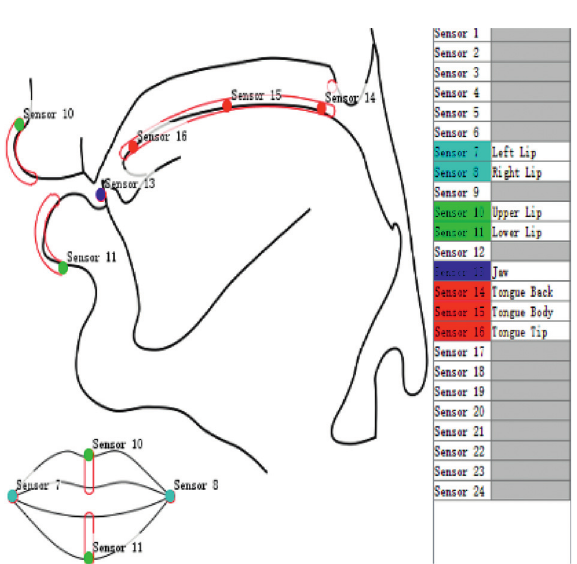
Figure 5: Sensor placements on the